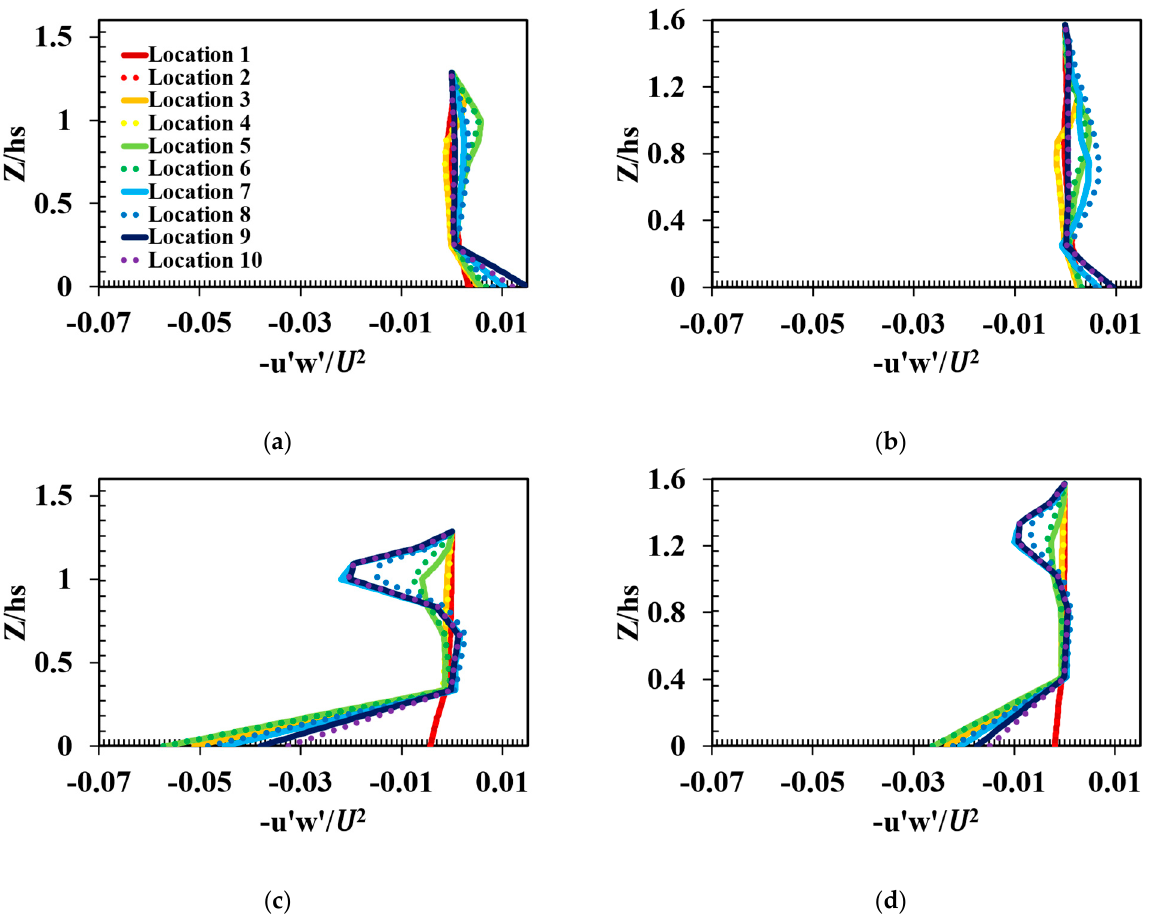
Figure 11. ( a – d ) The vertical profiles of shear stresses ( − u’w’ ) at specified locations: ( a ) case 1; ( b ) case 2; ( c ) case 3; ( d ) case 4. ( b ) case 2; ( c ) case 3; ( d ) case